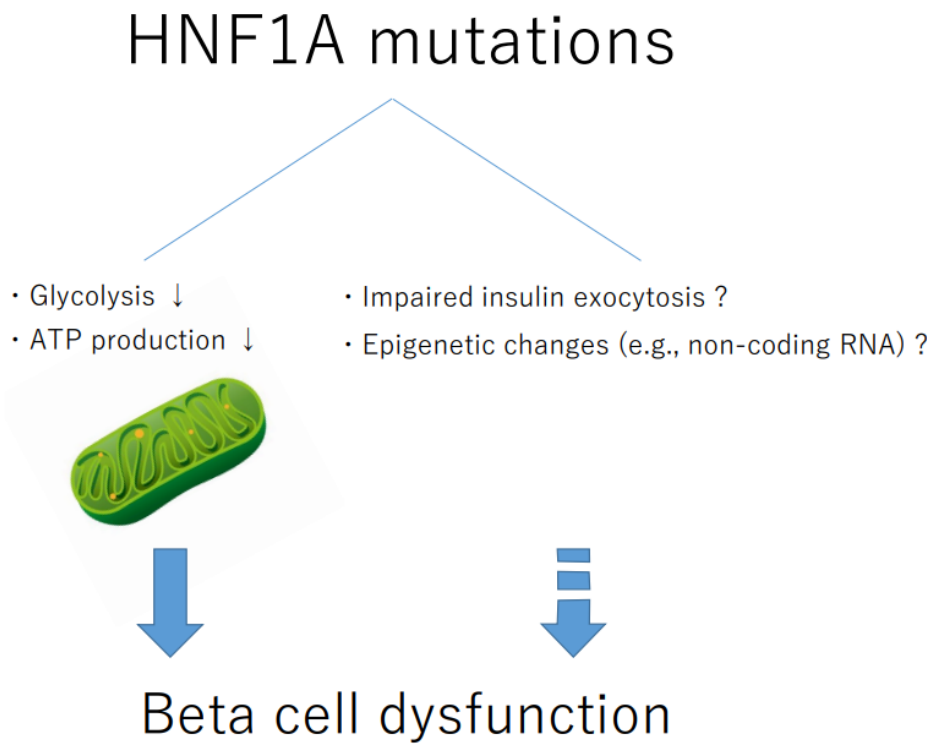
Figure 2. Schematic representation of beta cell dysfunction caused by HNF1A mutations. It is controversial whether HNF1A directly regulates mitochondrial function-related genes; these genes might be regulated through a network of transcription factors, such as PDX1 and HNF4A [104]. Loss of HNF1A in human embryonic stem (ES) cell-derived beta cells impairs mitochondrial respiration accompanied by a decrease in LINKA, a human- specific long non-coding RNA, suggesting the involvement of HNF1A in mitochondrial function [108]. Further studies are required to elucidate the role of HNF1A in regulating mitochondrial metabolism in beta